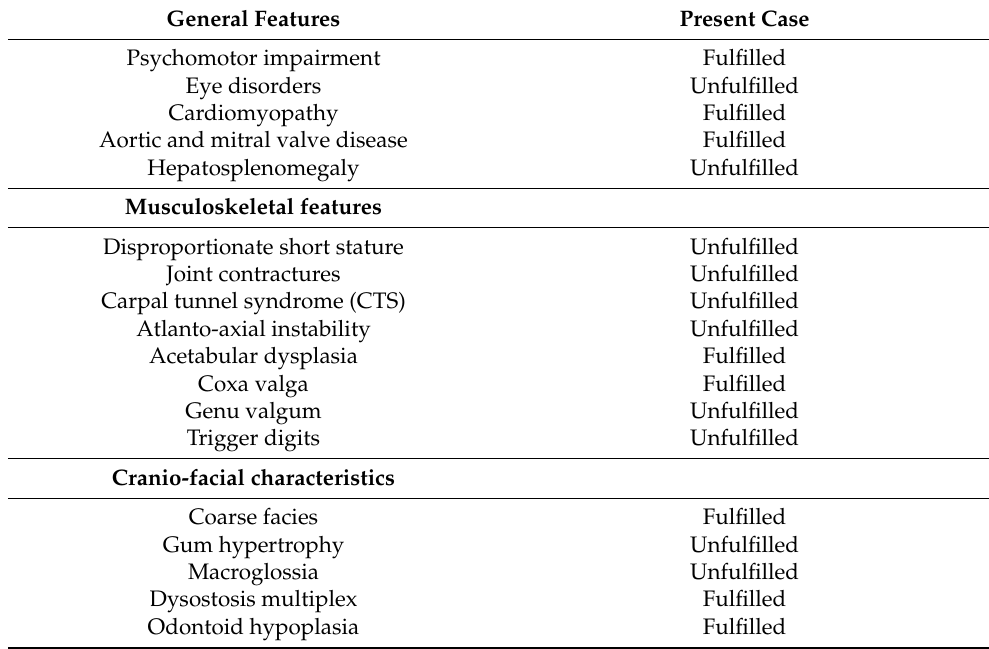
Table 1. Commonly described features in patients with MPS I, Hurler syndrome, compared to those observed in our